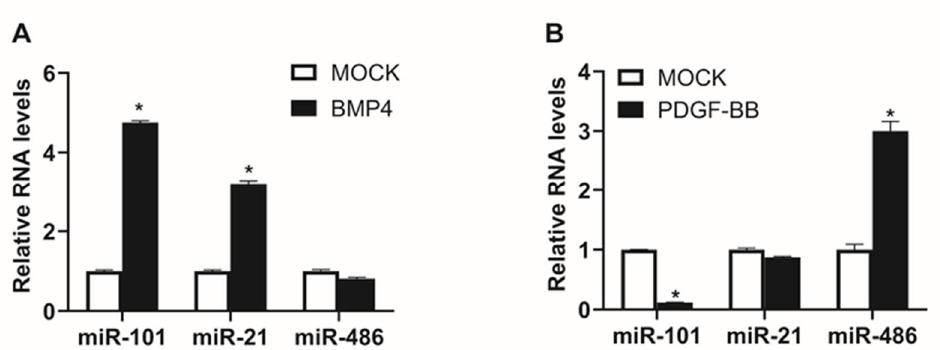
Figure 2. Bone morphogenetic protein (BMP) signaling regulates miR-101 expression. ( A , B ) Levels of miRNAs relative to U6 snRNA measured by qRT-PCR in PASMCs 24 h after treatment with BMP4 ( A ) or PDGF-BB ( B ). The data represent the means ± S.E. of triplicates. *, p < 0.05.